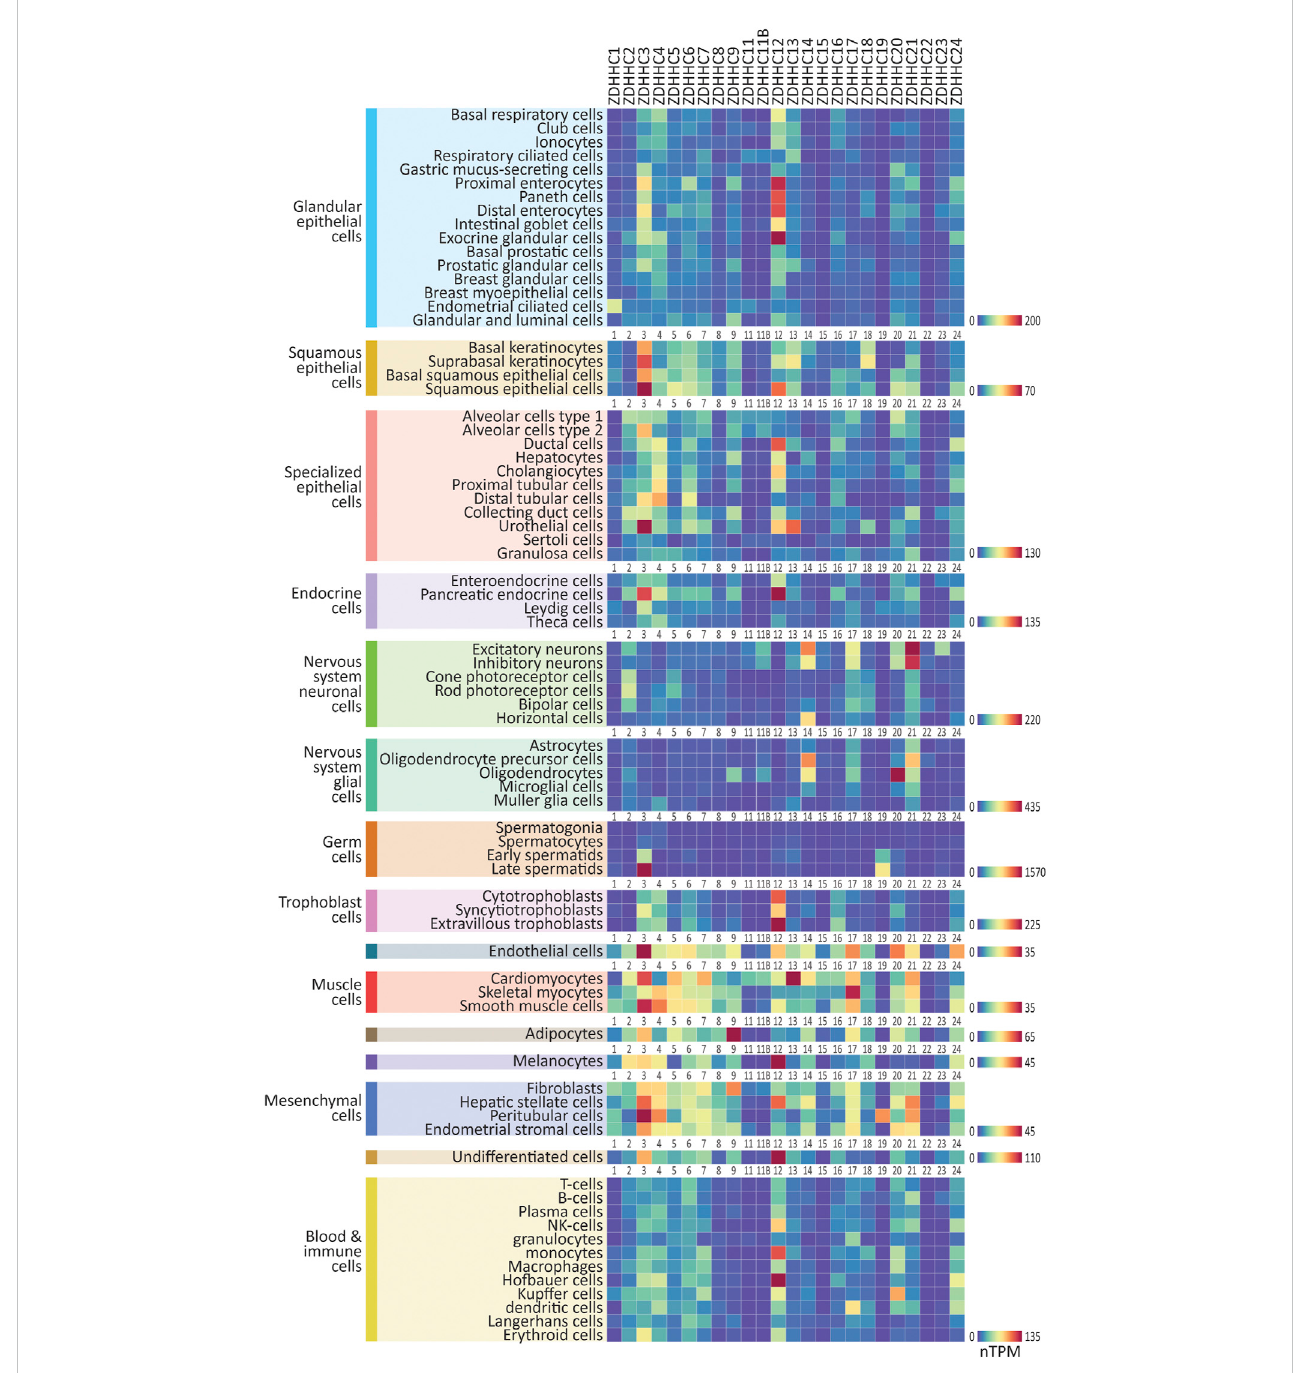
FIGURE 1 Expression patterns of the ZDHHC enzymes in major human cell types. Heatmaps showing human single-cell RNAseq expression data for the ZDHHC enzymes, downloaded from the Human Protein Atlas. 76 major cell types were identi fi ed within 15 cell type clusters. Heatmaps are grouped according to cell type cluster to view relative expression. Heatmap units: TPM. All data available for download on